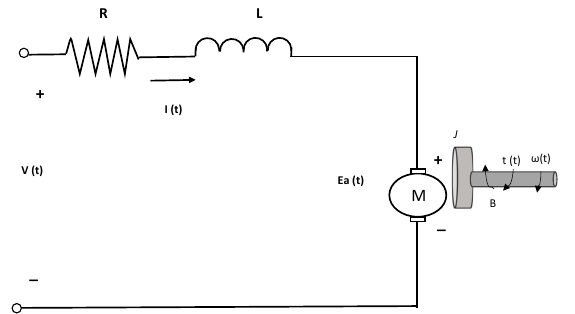
Figure 1: Schematic diagram for DC motor. Figure 1. Schematic diagram for a DC motor.